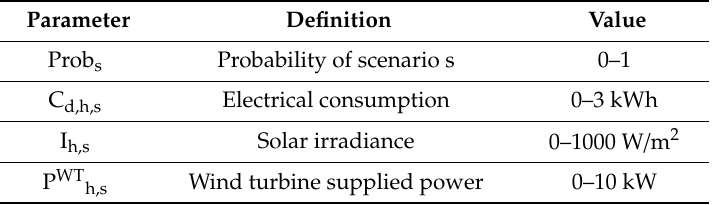
Table 4. Parameters related to the sources of uncertainty or stochastic parameters of the physical constraints.